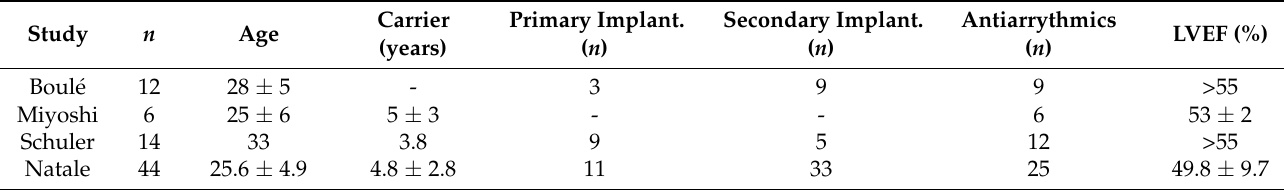
Table 1. Overview of the four retrospective studies describing pregnancy with an implantable cardioverter defibrillator (ICD). The age of pregnancy, the duration of ICD carriage before pregnancy, the reason for implantation (primary vs. secondary prevention of sudden cardiac death), the number of people taking antiarrhythmics and the left ventricular ejection fraction (LVEF) is given.